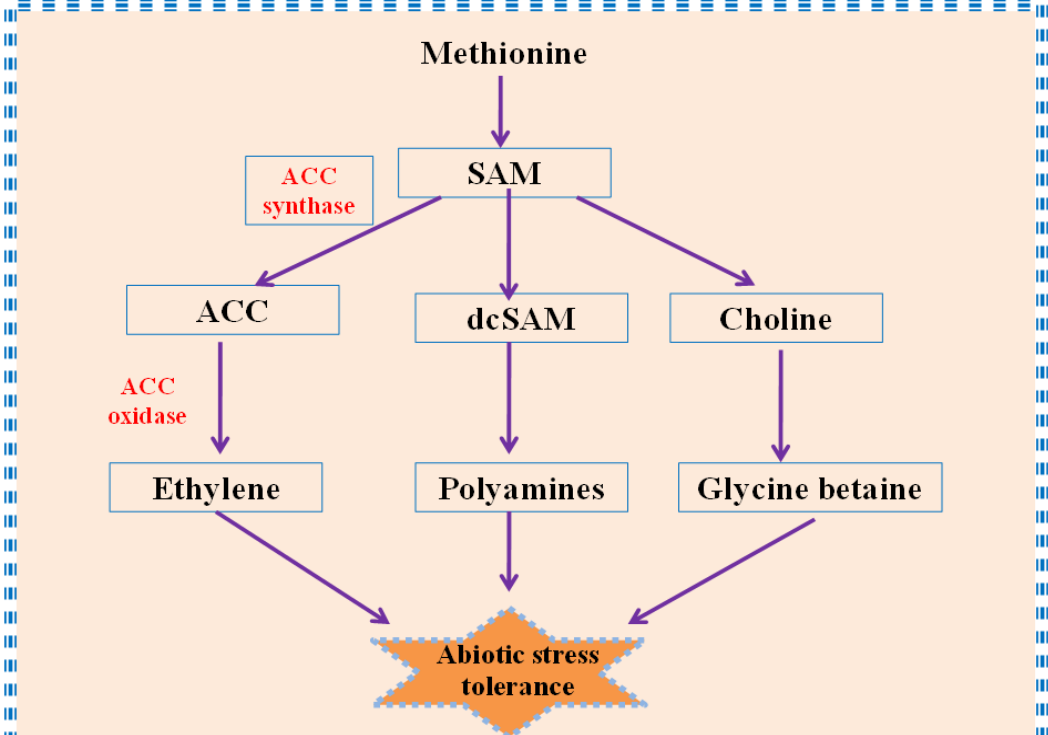
Figure 3. Role of ethylene, glycine betaine (GB), and polyamines under abiotic stress, after their formation through a common precursor, S-adenosylmethionine (SAM). (ACC: 1-amino-cyclo-propane-1-carboxylic acid; SAM: S-adenosyl methionine; dcSAM: SAM decarboxylase enzyme).